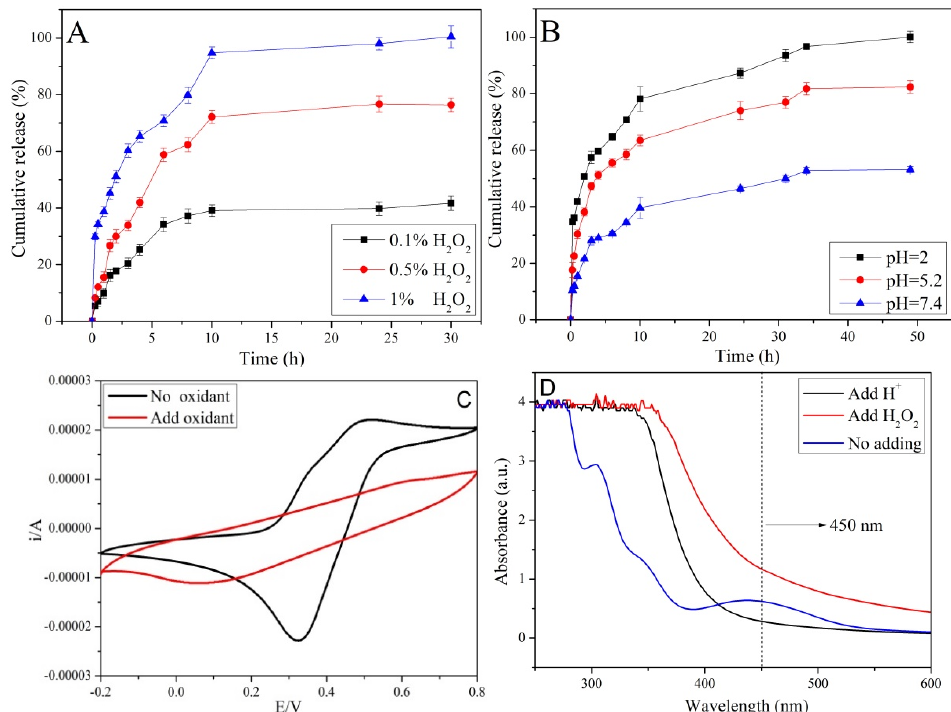
Figure 7. The release of NAP at different concentrations of H 2 O 2 ( A ), release of DOX at different pH ( B ), the cyclic voltammetry curve ( C ), and the UV–Vis spectra of nanoparticles at different statuses ( D ).